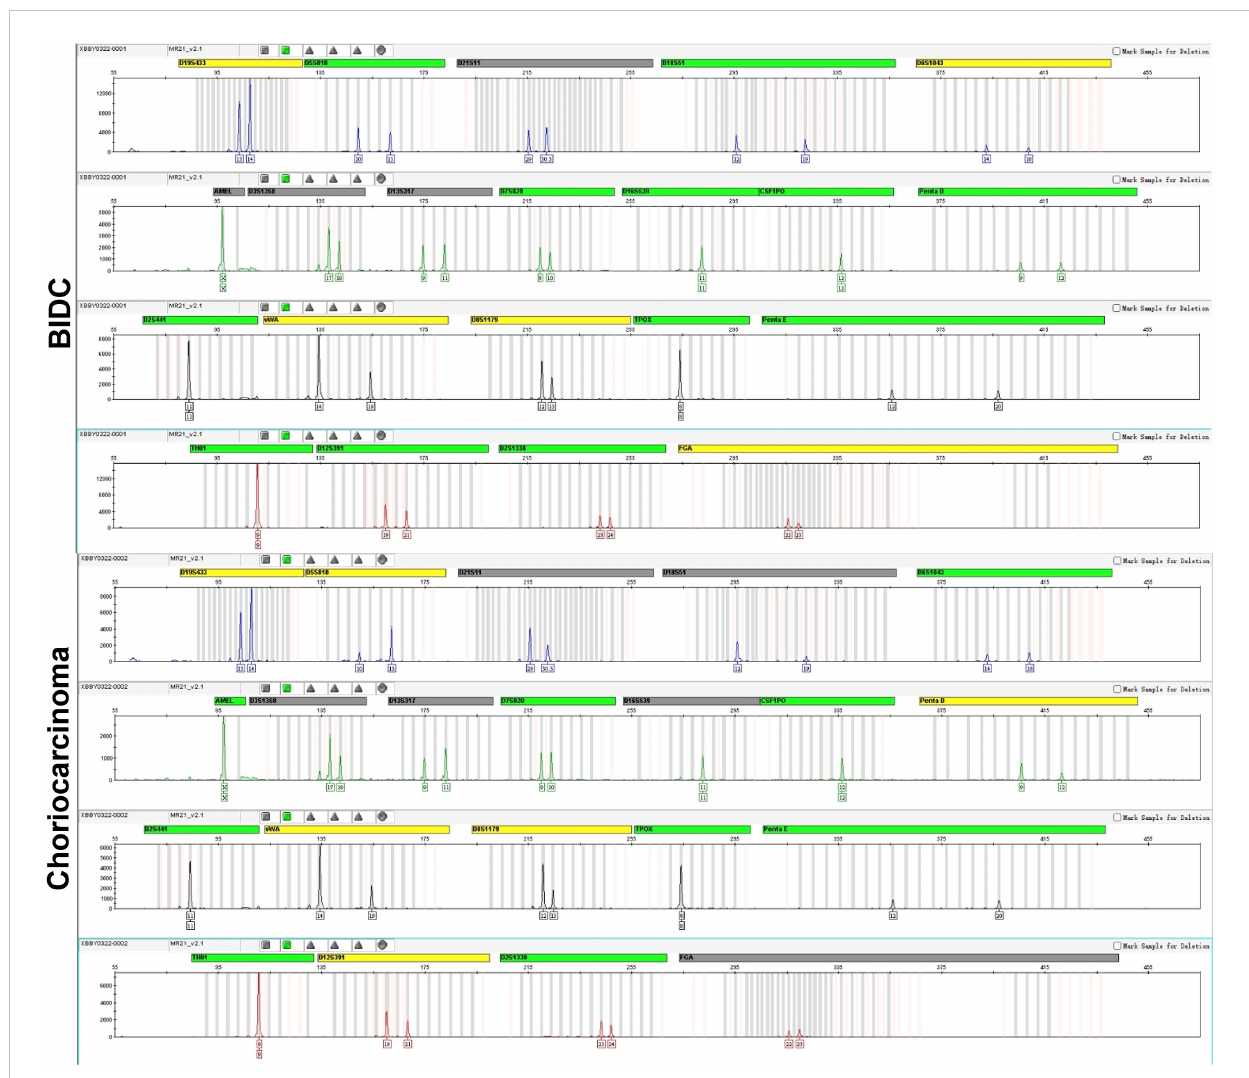
FIGURE 3 DNA STR analysis. DNA STR analysis reveals the genomic DNA alleles of the choriocarcinomatous differentiated components are identical to those of the BIDC components, exhibiting that the choriocarcinoma is